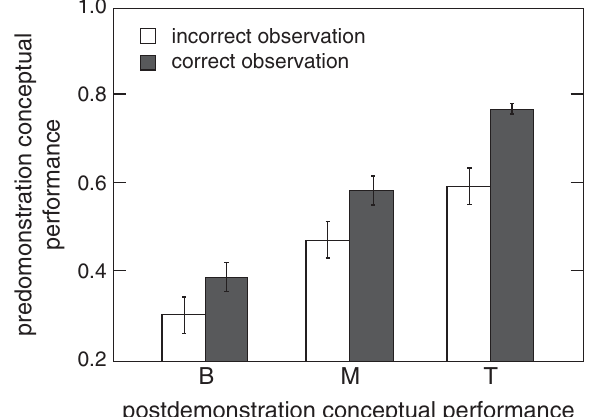
FIG. 3. Comparison of the postdemonstration conceptual performance for students who responded correctly to the initial outcome question (gray) to students who responded incorrectly (white), for students at three different levels of performance on the predemonstration conceptual questions: bottom third of the class (B), middle third of the class (M), and top third of the class